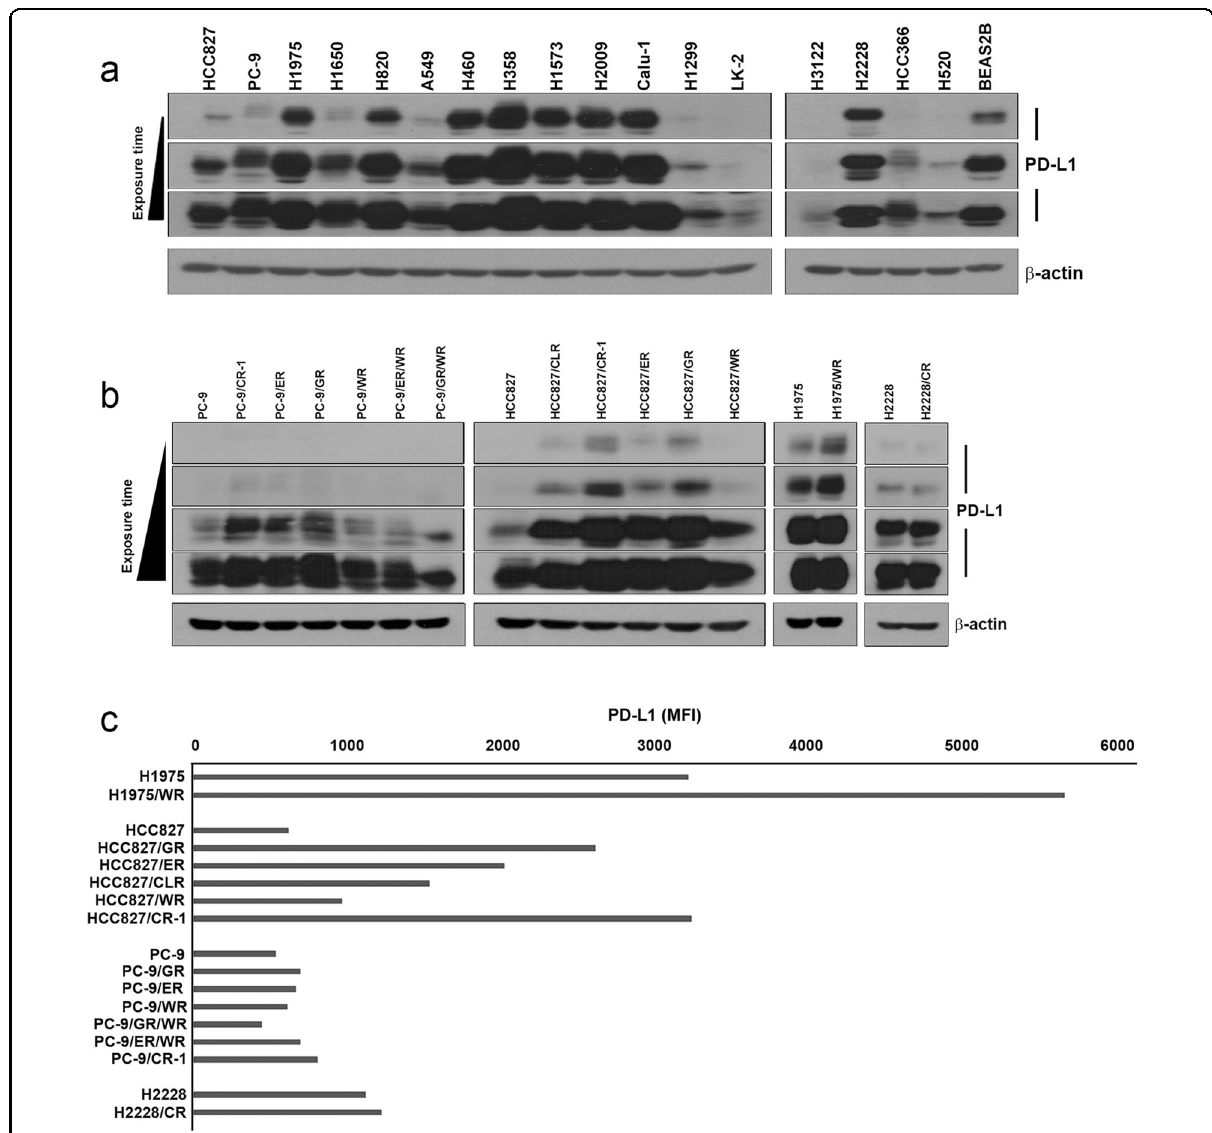
Fig. 1 The expression of PD-L1 in NSCLC cell lines and cells with acquired resistance to various anticancer drugs. a The basal expression of PD-L1 in NSCLC cells was determined by western blot analysis. b , c PD-L1 expression in parental and resistant cells was determined by western blot analysis and fl ow cytometry. MFI, median fl uorescence intensity; CR-1, cisplatin resistance; GR, ge fi tinib resistance; ER, erlotinib resistance; WR, WZ4002 resistance; CLR, CL-387785 resistance; CR, crizotinib